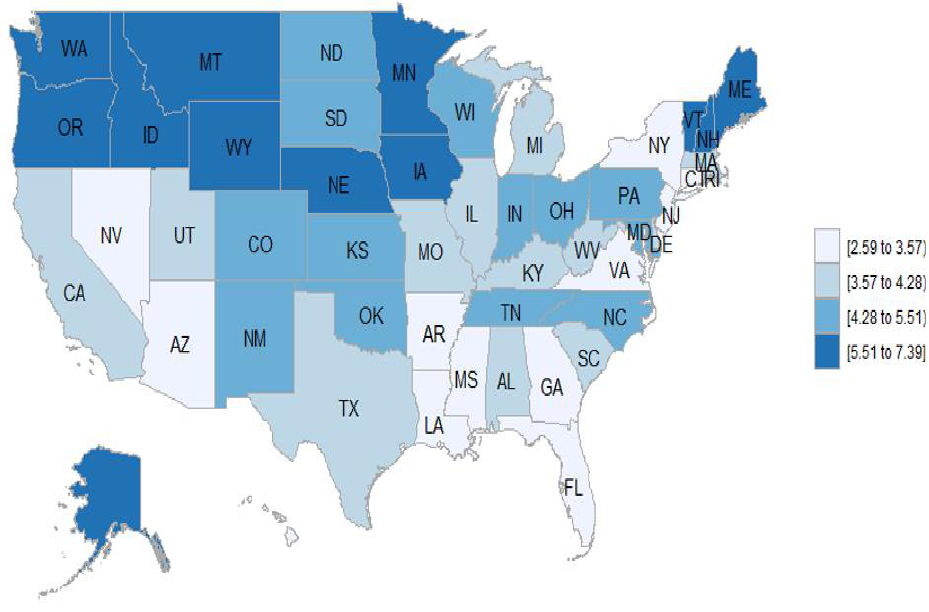
Figure 2. Age-adjusted mortality rates per million for vasculitis as multiple cause of death, by state, from 1999 to 2019.